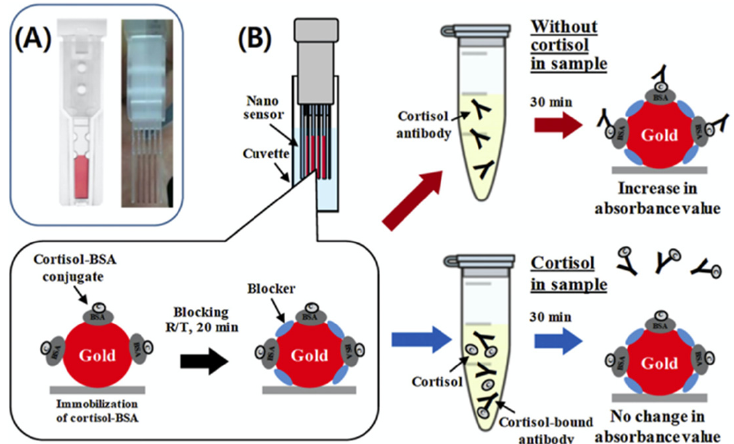
Figure 2. ( A ) Real image of a Plex NanoCuve before (right) and after (left) installation in a cuvette. ( B ) Schematic of the competitive cortisol test with the Plex NanoCuve (reproduced with permission from [46] Copyright 2018 Elsevier).